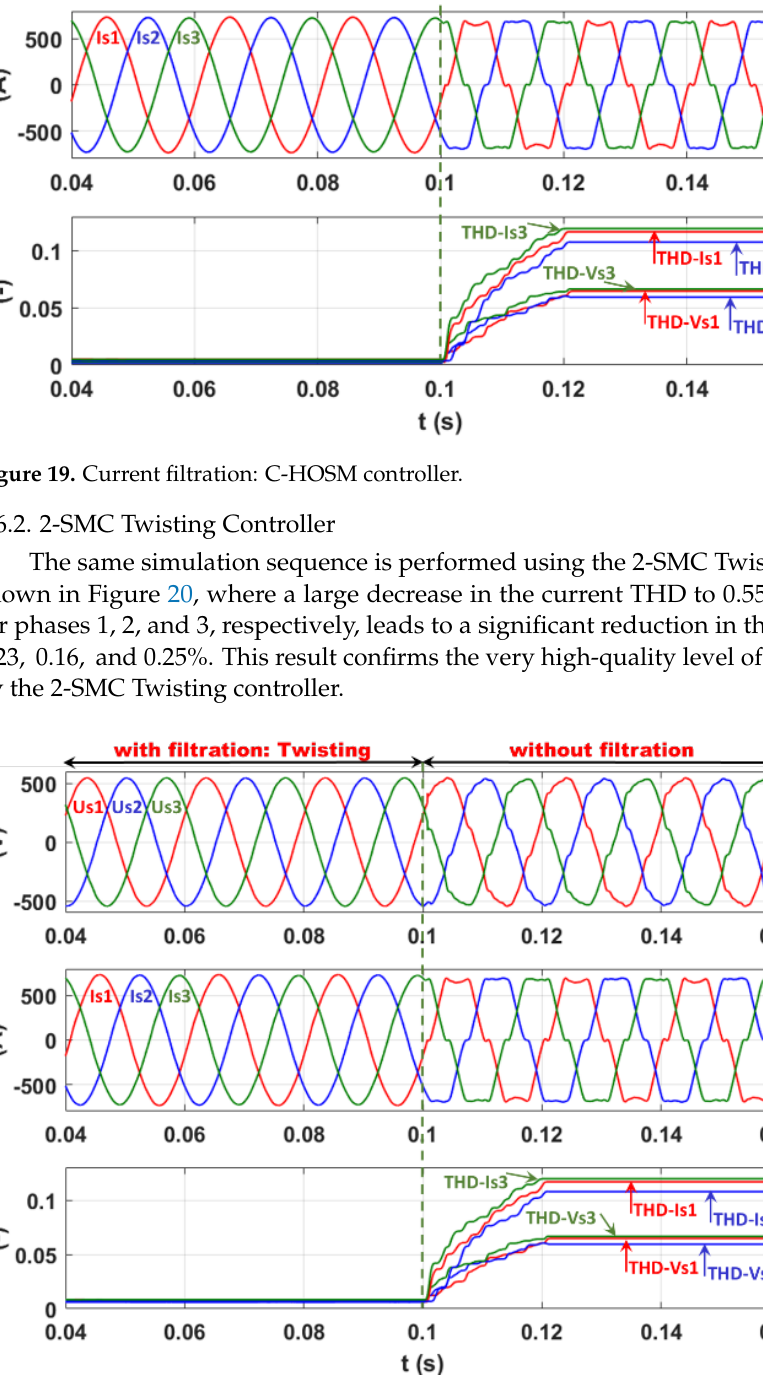
Figure 20. Current filtration: 2-SMC Twisting controller.